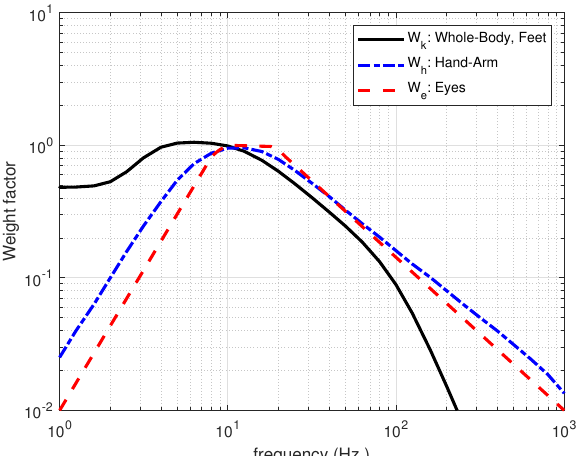
Figure 2. Frequency weights of vertical whole-body and feet vibration ( W k ), hand-arm vibration ( W h ), and eye vibration ( W e